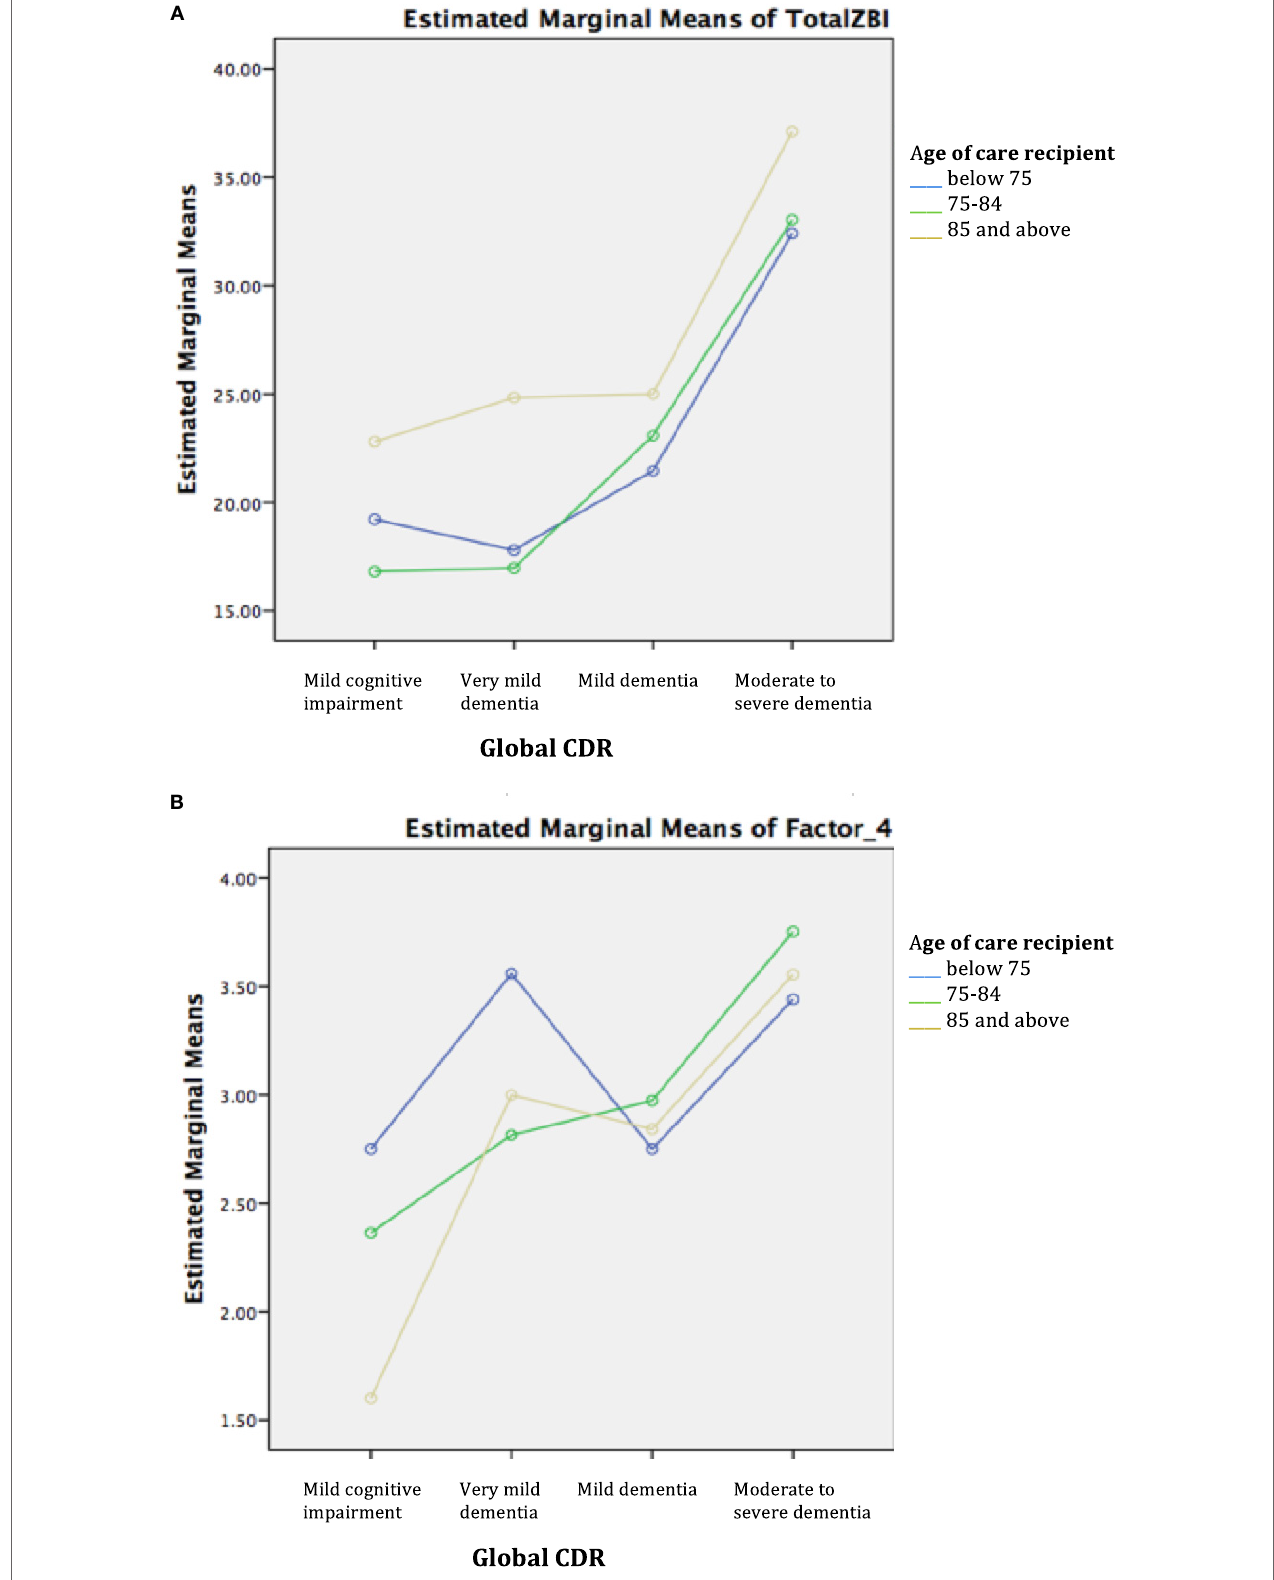
FigUre 1 | (a) Trend of total Zarit Burden Interview (ZBI) across disease severity by age group. (B) Trend of factor 4 across disease severity by age